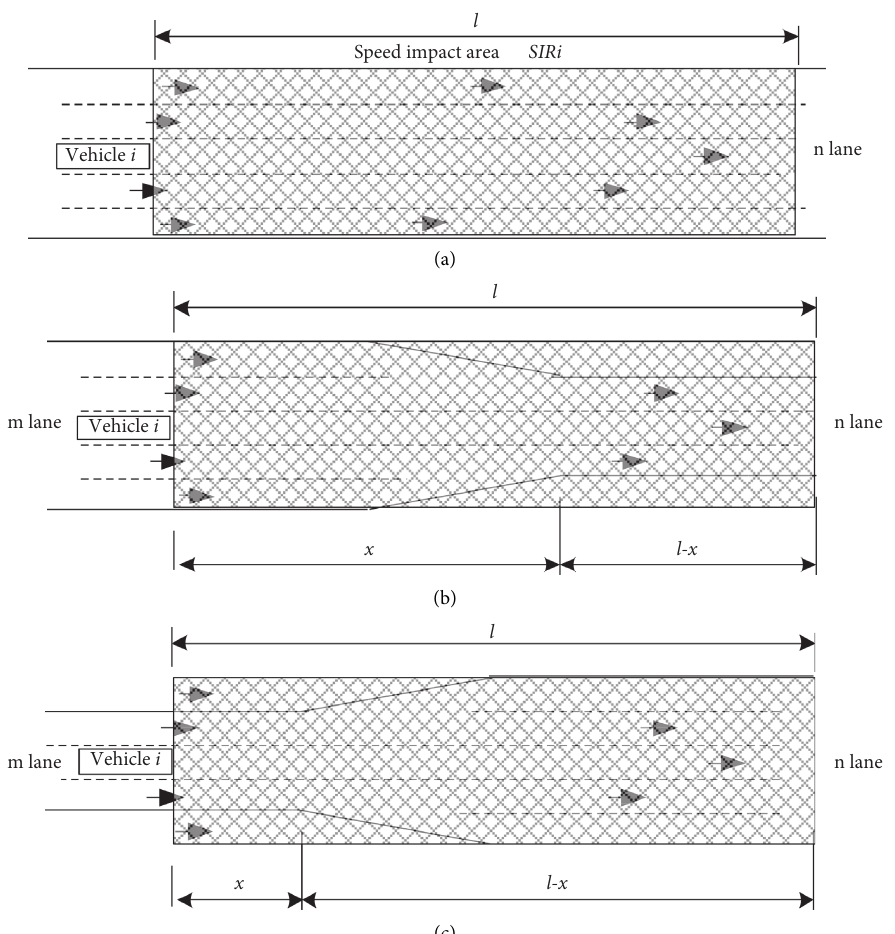
Figure 3: SIR of the Model. (a) Equal number of lane road sections. (b) Reduced number of lanes roads. (c) Increased number of lanes roads.